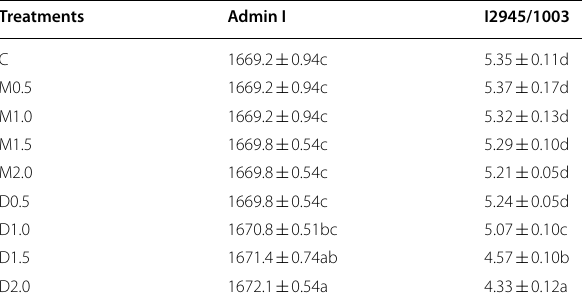
Different letters (a-g) in a column indicate significant differences ( p < 0.05 ) between treatments with same concentration of different polysaccharides